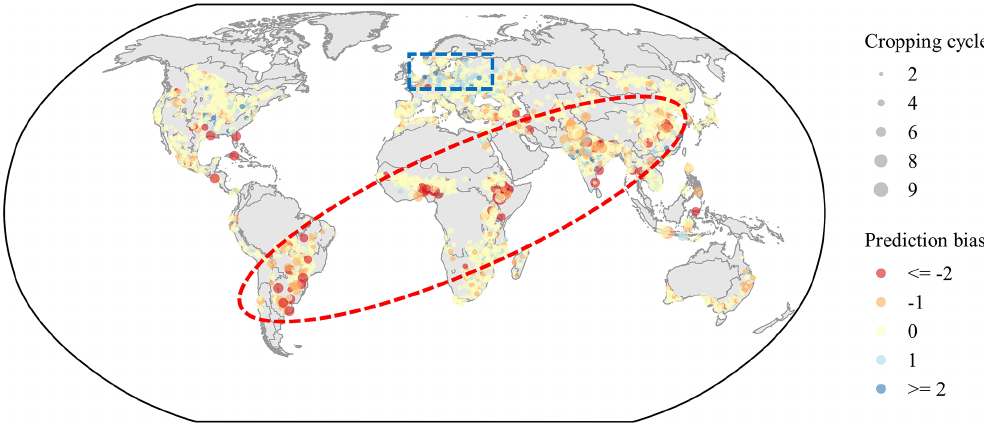
Figure 4. Spatial distribution of RDsat-based TNCC bias. The actual TNCC is proportional to its point size, and the prediction biases are identified by different point colours. Sample points identified as the continuous-cropping type were excluded. The blue rectangle indicates overestimations, and the red ellipsis region represents the northward “underestimation belt” along the longitudinal gradient.